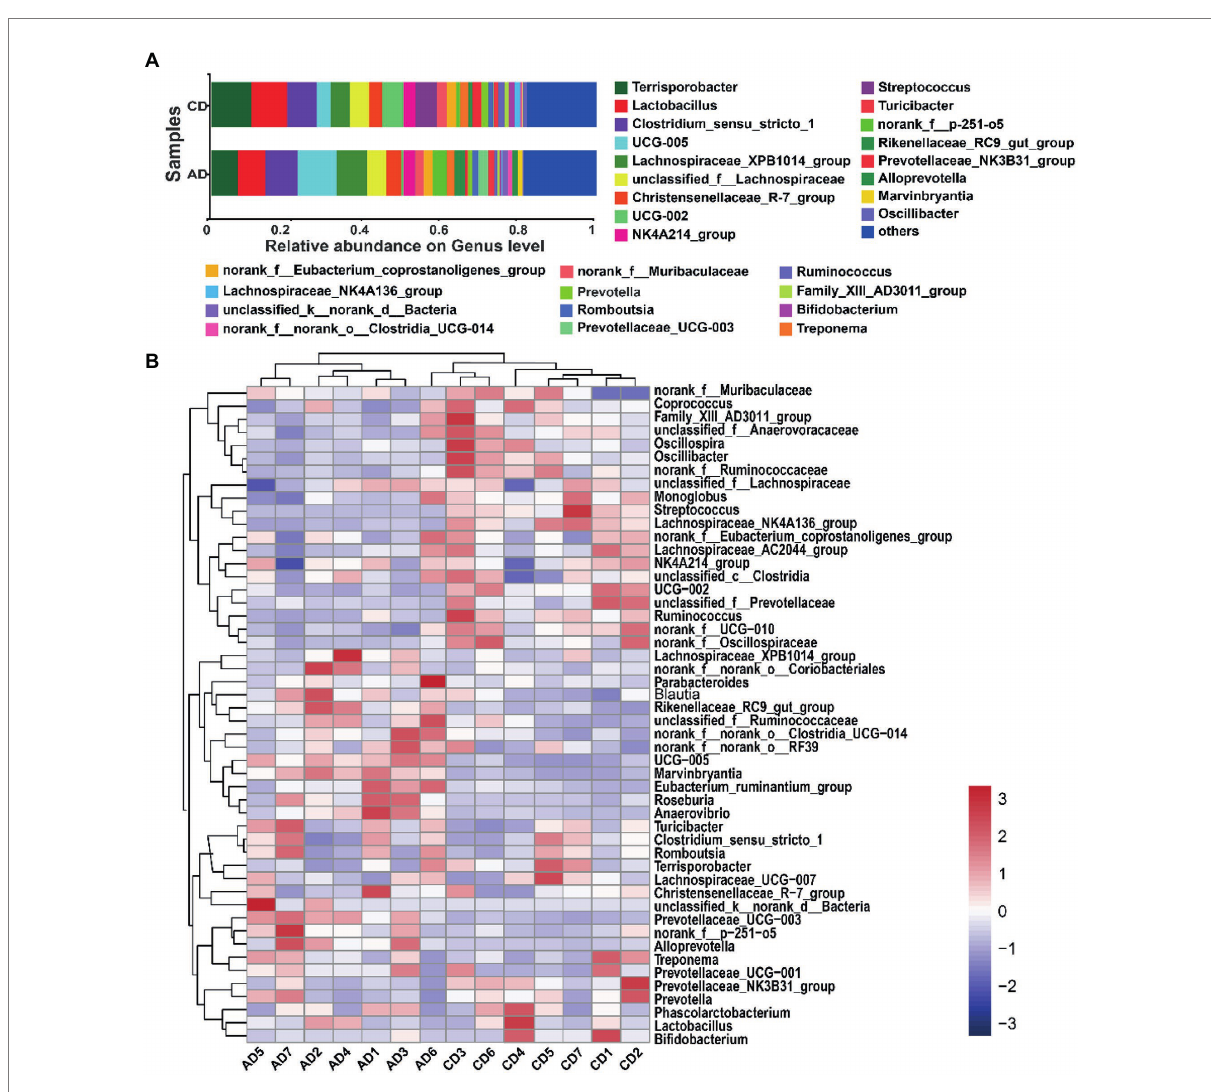
FIGURE 4 Microbial community. Microbiota composition of colonic digesta and relative abundance (>0.01) at genus levels (A) . Hierarchically clustered heatmap analysis of microbial community (top 50) among 14 samples at the genus level (B) . CD, control diet; AD, alfalfa